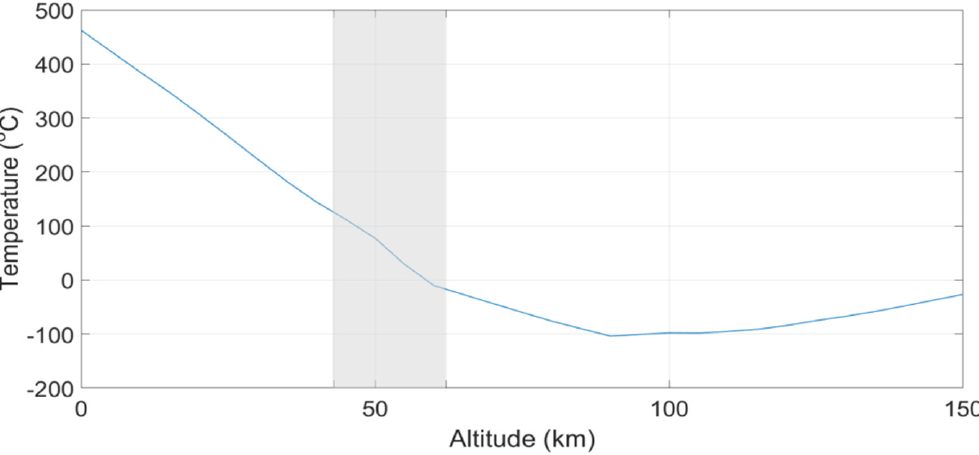
Figure 1. Temperature profile of Venus (data from [26–28]).